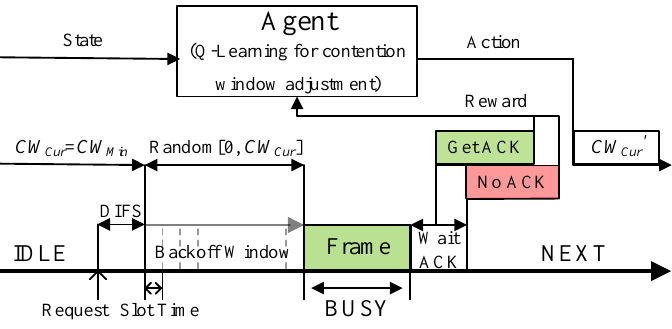
Figure 4. The contention process of the QMAC-2ND.